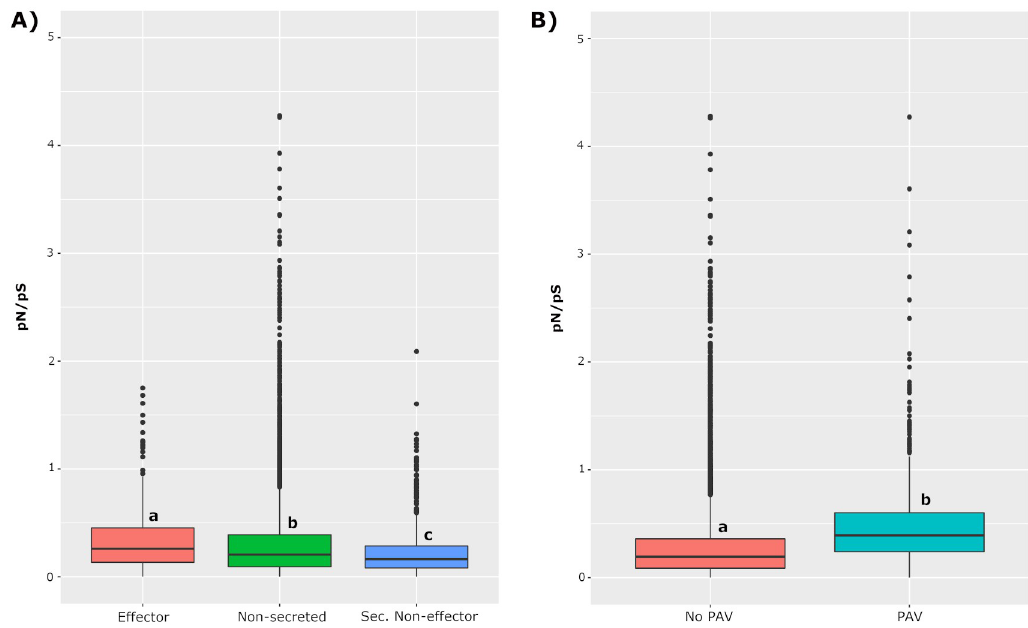
Fig 7. Distribution of pN/pS ratios among genes encoding (A) predicted effectors, secreted non-effectors, non-secreted proteins, and (B) genes exhibiting PAV. Categories are displayed on the x-axes and the log transformed pN/pS ratio is illustrated on the y-axes. Color legends are displayed to the right of each figure. Letter codes correspond to statistically different groups (Pairwise Wilcoxon Rank Test, p < 0.01). Outliers of pN/pS values greater than 10 are not displayed.